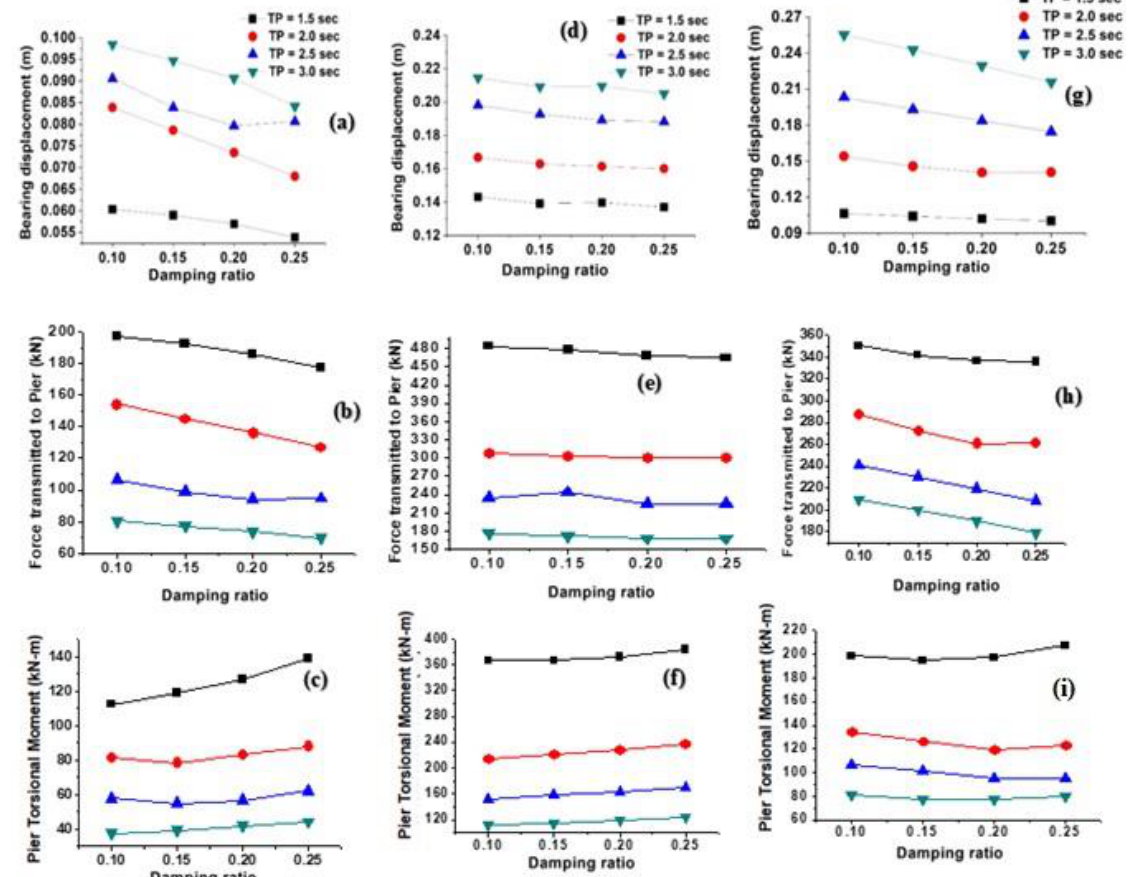
Figure 9. The Bridge Response sensitivity with respect to the damping ratio of LRBs under uni- directional (i) Imperial Valley ( a – c ), (ii) Kobe ( d – f ), and (iii) Turkey ( g – i ) ground motions .